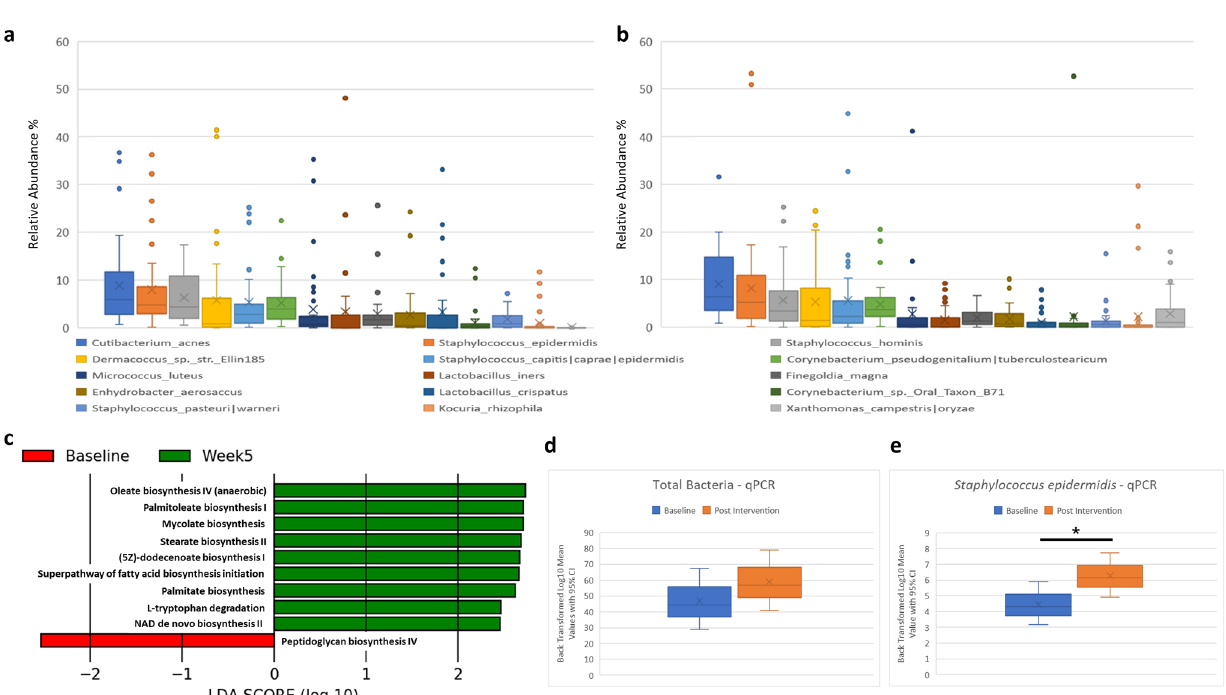
Figure 3. Skin microbiome assessment at baseline and after 5 weeks of product application. Box and whisker plots summarising the dominant species at ( a ) baseline and at ( b ) Week 5. ( c ) LEfSe analysis of differential microbiome function identified at baseline and Week 5. qPCR analysis of ( d ) total bacterial count and ( e ) Staphylococcus epidermidis at baseline and post